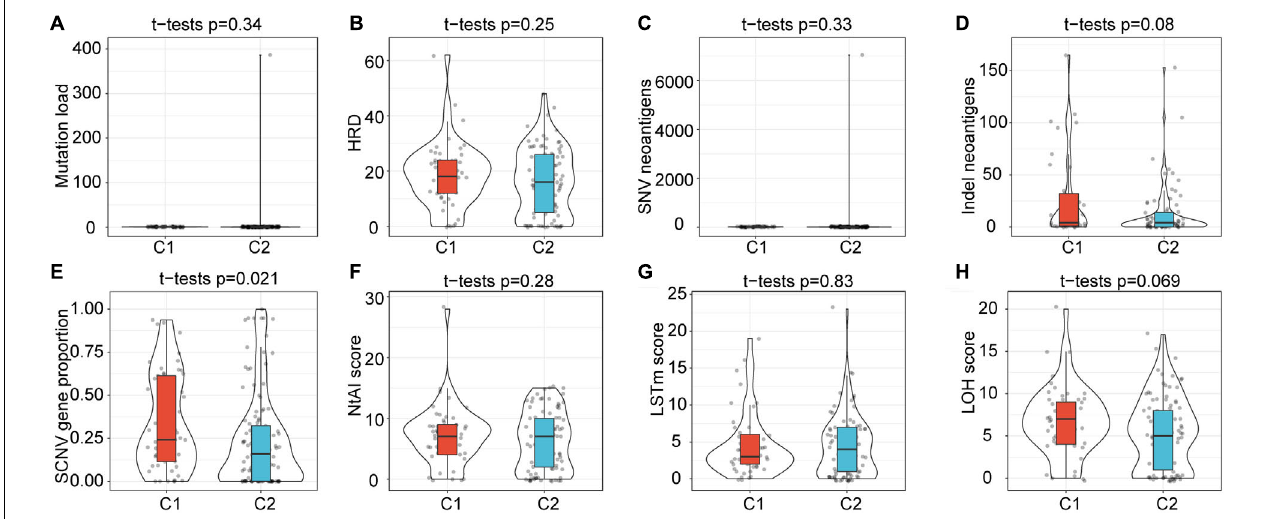
FIGURE 5 | Differences in factors related to innate immune escape between subtypes. (A–H) Differences among subtypes in Mutation load, HRD, SNV neoantigens, Indel neoantigens, SCNV gene proportion, Ntal score, LSTm score and LOH score. Among them, only the SCNV gene proportion shows significant difference between